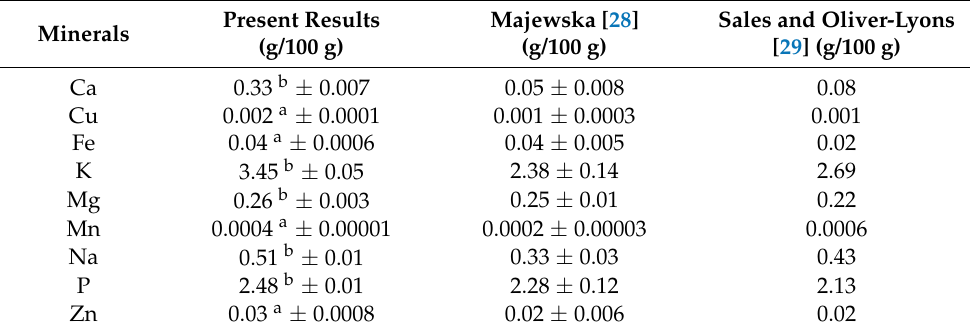
Table 7. Mineral composition of ostrich outside strip ( n = 10) compared to the literature. Minerals